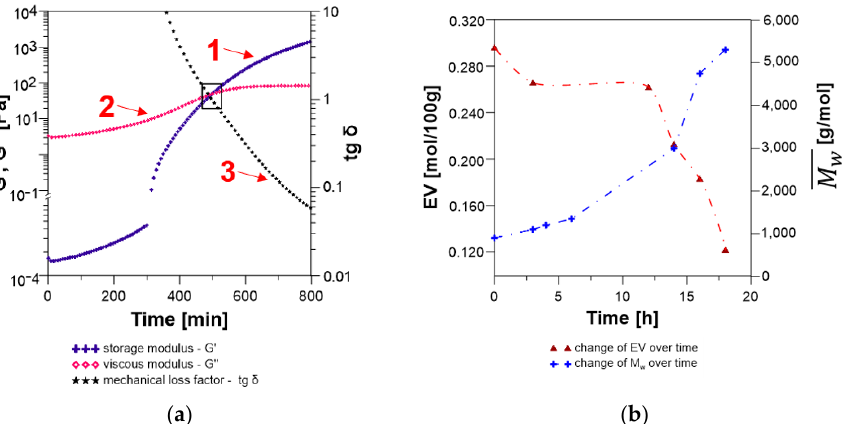
Figure 8. ( a ) Changes in the storage modulus (curve 1), loss modulus (curve 2), and the loss tangent tg δ (curve 3) over time for the polyaddition process of epoxidized soybean oil with bisphenol A; ( b ) changes in oxirane group content (EV) and molecular weight during the process